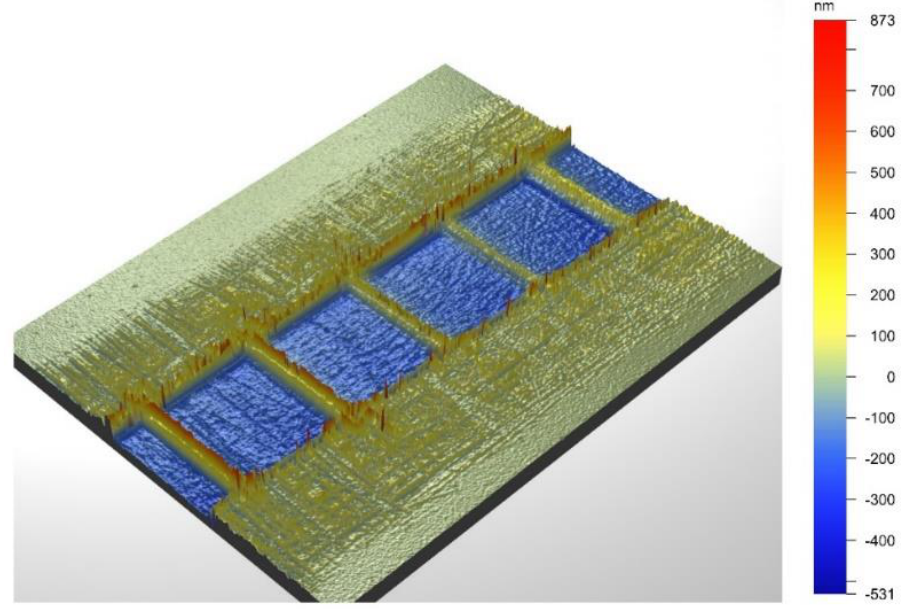
Fig. 5 3D view of laser ablation with separate pulses (the color scale bar represents the height profile in